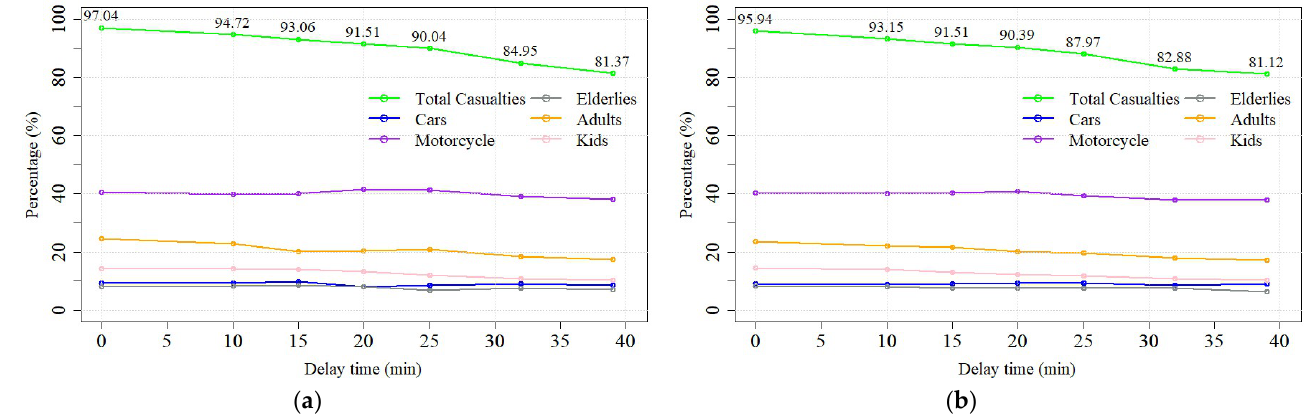
Figure 12. Comparison of the evacuee (%) from ( a ) the VESs and HES simulation and ( b ) the HES simulation.